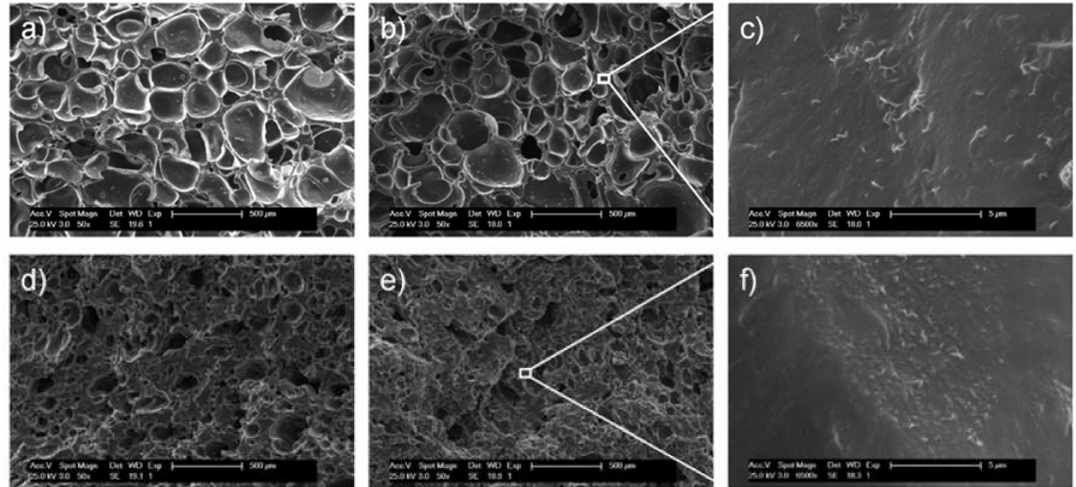
Figure 2. SEM micrographs of cryofractured ethylene–propylene–diene monomer (EPDM) / MWCNT nanocomposite foams containing ( a ) 0, ( b ) 2, ( d ) 6, and ( e ) 10 phr MWCNTs. ( c , f ) Micrographs of the MWCNTs within the morphology.